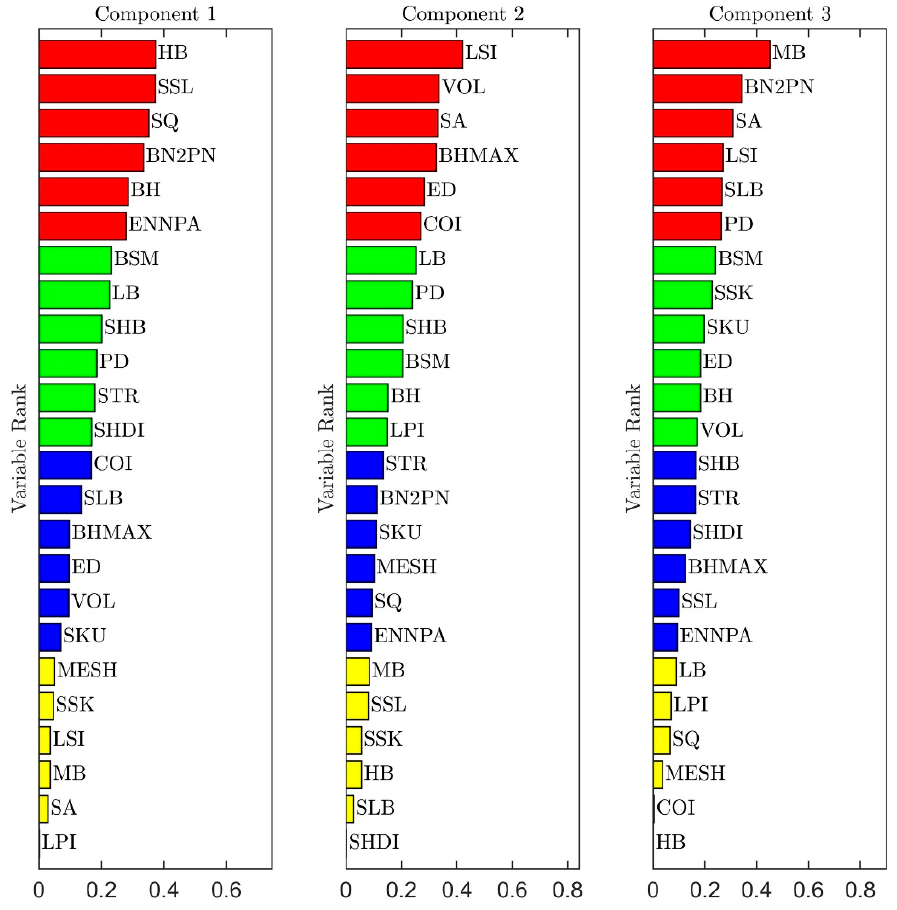
Figure 5. Dominant building characteristics for the first three main components. X axis means contribution of metrics on each component.